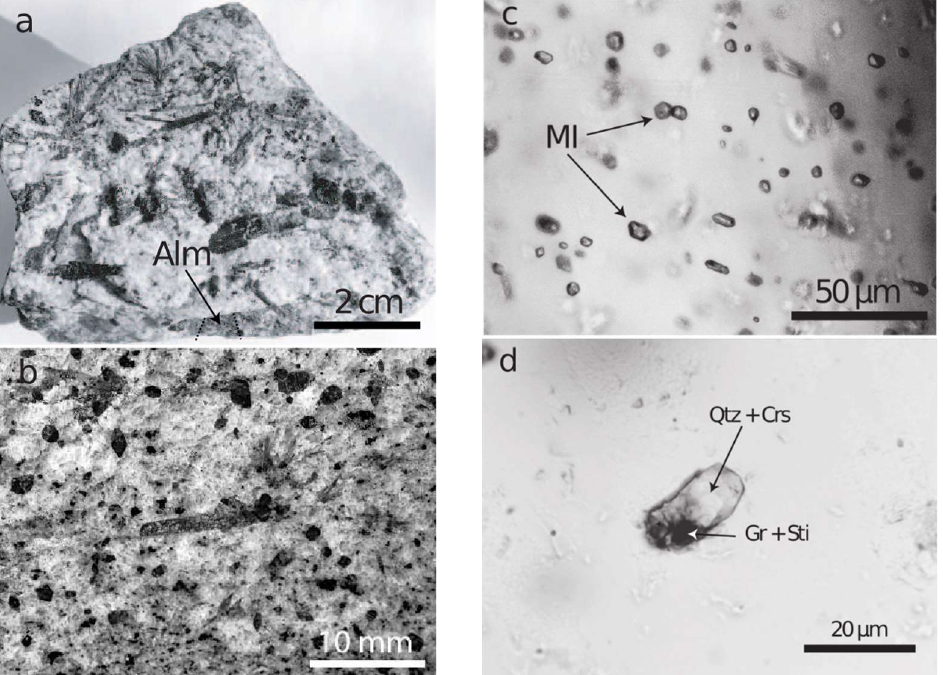
Figure 1. Hand specimen ( a ) of a prismatine-bearing granulite from Waldheim/Saxony. All dark grains are prismatine crystals. Alm—almandine. ( b ) Prismatine-bearing granulite. In the center, a needle-shaped prismatine crystal beside more euhedral or subhedral dark grains of prismatine in a granulite matrix. ( c ) Melt inclusions in almandine. ( d ) Melt inclusion in almandine after the first Raman measurement: Crs—cristobalite, Gr—graphite, Qtz—quartz, Sti—remnants of stishovite.